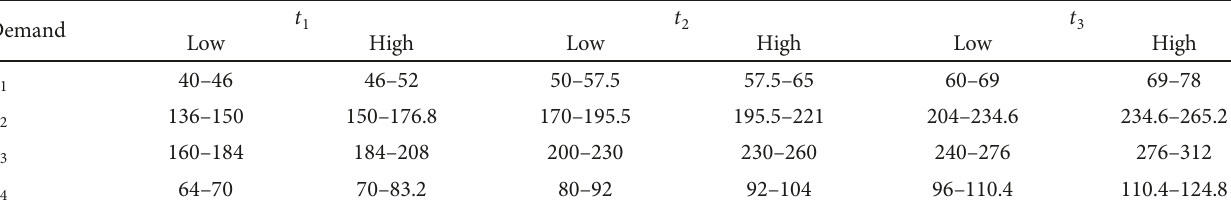
Figure 1: Scenario tree for the stochastic load demand in bus 1. Table 2: Maximum and minimum demand by bus MWh/ h